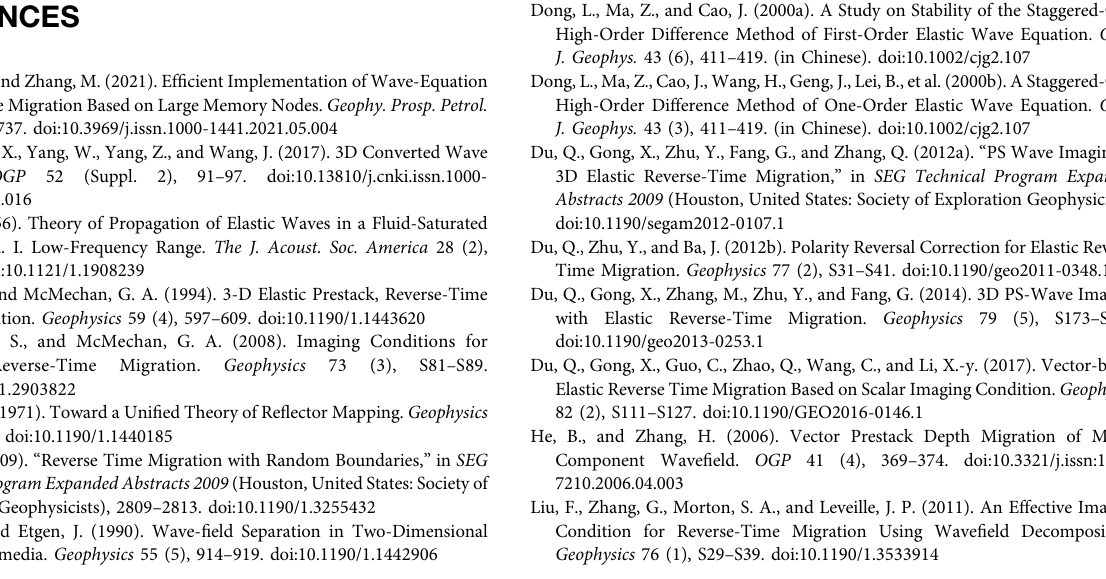
The fi rst-order velocity-dilatation-rotation elastic wave equations